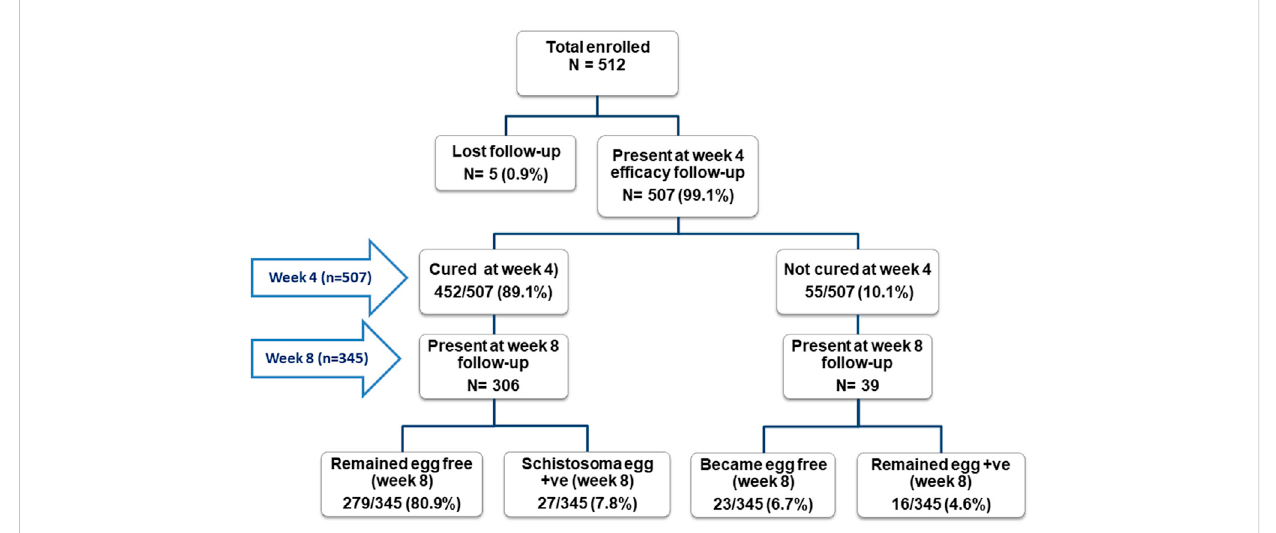
FIGURE 1 Study fl ow chart and observed cure rates strati fi ed by treatment follow-up visits (in weeks).